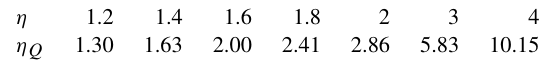
Table 2. Numerical experiments for saltation-bombardment